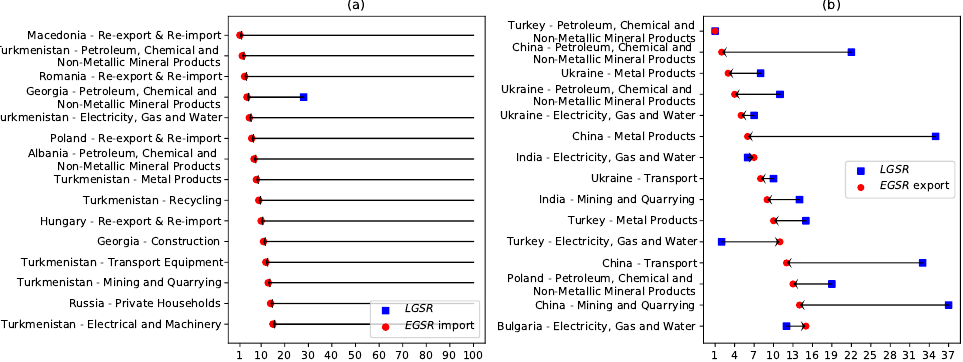
Figure 7. Change of rankings from the LGSR s to EGSR for the top 15 sectors with the highest EGSR . ( a ) from LGSR s to EGSR imports; ( b ) from LGSR s to EGSR